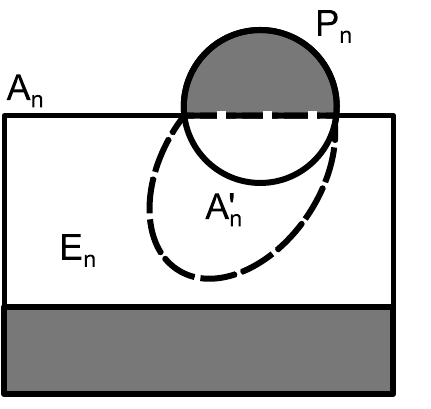
Fig 2. The three characteristic sets of assemblies in an assembly system. The set of assembled patterns A n contains some target patterns ( A n \ P n ) that are already assembled, the set of promising patterns \ P A 0 n as well as nontarget patterns that will eventually become target patterns of larger n that includes A n size n , and the remaining error assemblies ( E n ¼ A n (cid:6) A 0 n